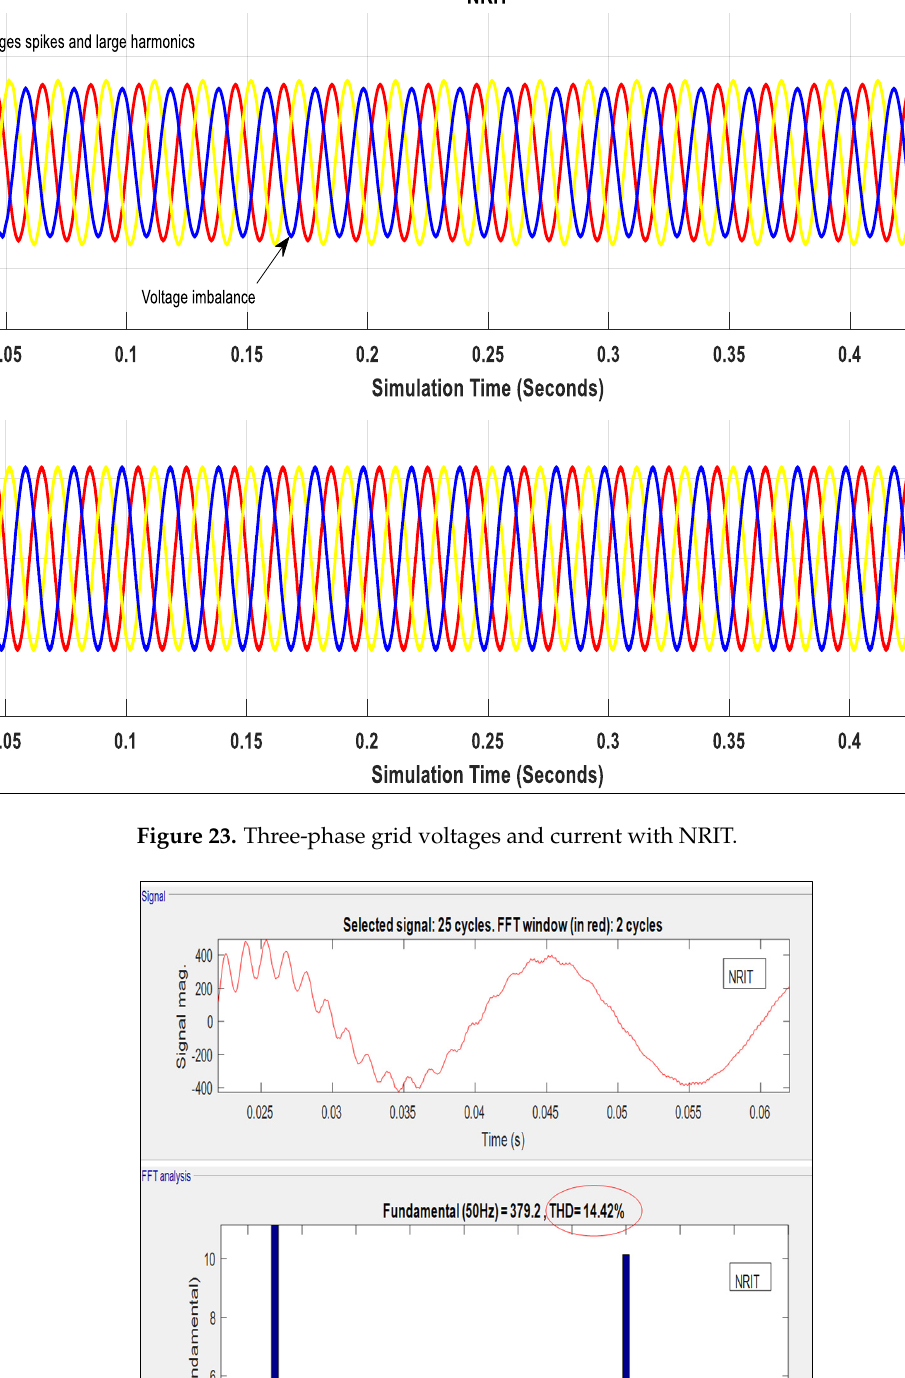
Figure 22. The THD case study 3 performance results with ICLS-DSOGI-PLL.